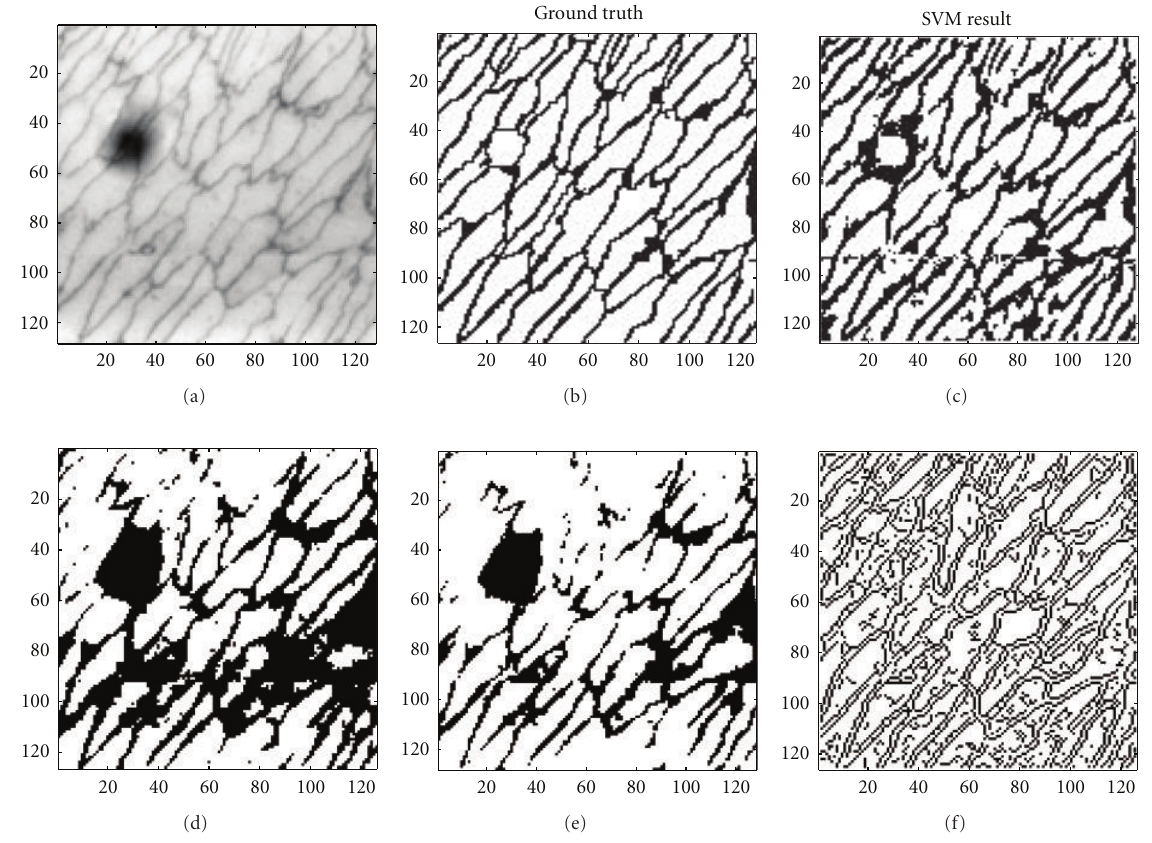
Figure 9: Comparison of results from di ff erent image segmentation techniques.(a, b, c): original image with its ground truth and SVM segmentation results. (d, e, f): Kittler method, Otsu method, and Canny edge detection results.